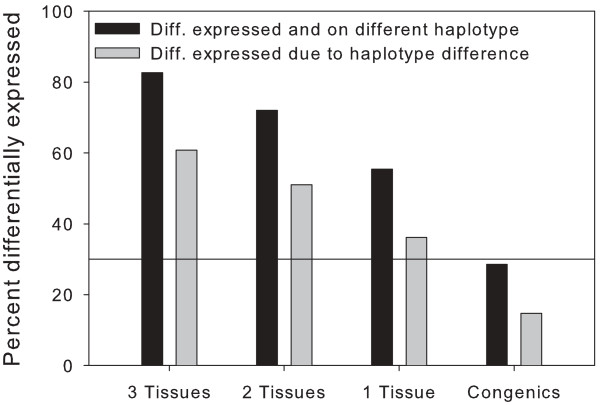
Frequency of differentially expressed genes on different haplotypes and attributable to haplotype difference. The proportion of the genes that were differentially expressed and also on different haplotypes in the parental C57BL/6 and A/J mice was obtained for all combinations of the three tissues at pplr thresholds of 0.005 (see Fig 3a for numbers). The percentages of genes that were differentially expressed and on different haplotypes are shown by the solid black bars, the percentages of genes that were estimated using Bayes Theorem to be differentially expressed due to haplotype differences are shown by the grey bars. 30% of the genes in A/J mice were on different haplotypes from C57BL/6, indicated by the horizontal bar on the plot. There was a significant excess of differentially expressed genes on different haplotypes in the parental mice but not in the congenic mice when the congenic region was excluded. Key "3 tissues" (kidney, liver, spleen) in parental mice (C57BL/6 and A/J); "2 tissues" - mean of the three combinations of two out of three tissues from the parental Mice; "1 tissue" - mean of individual tissues from the parental mice; "Congenics" - mean of the genes that were differentially expressed in the congenic mice and on different haplotypes in the parents for for the Tir1 (liver and spleen) and for Tir3 (liver) congenic excluding the congenic region. The percentage of genes that are differentially expressed in the congenic mice and on different haplotypes in the parents is expected to approximate to the percentage of genes on different haplotypes in the parents as was found to be the case.